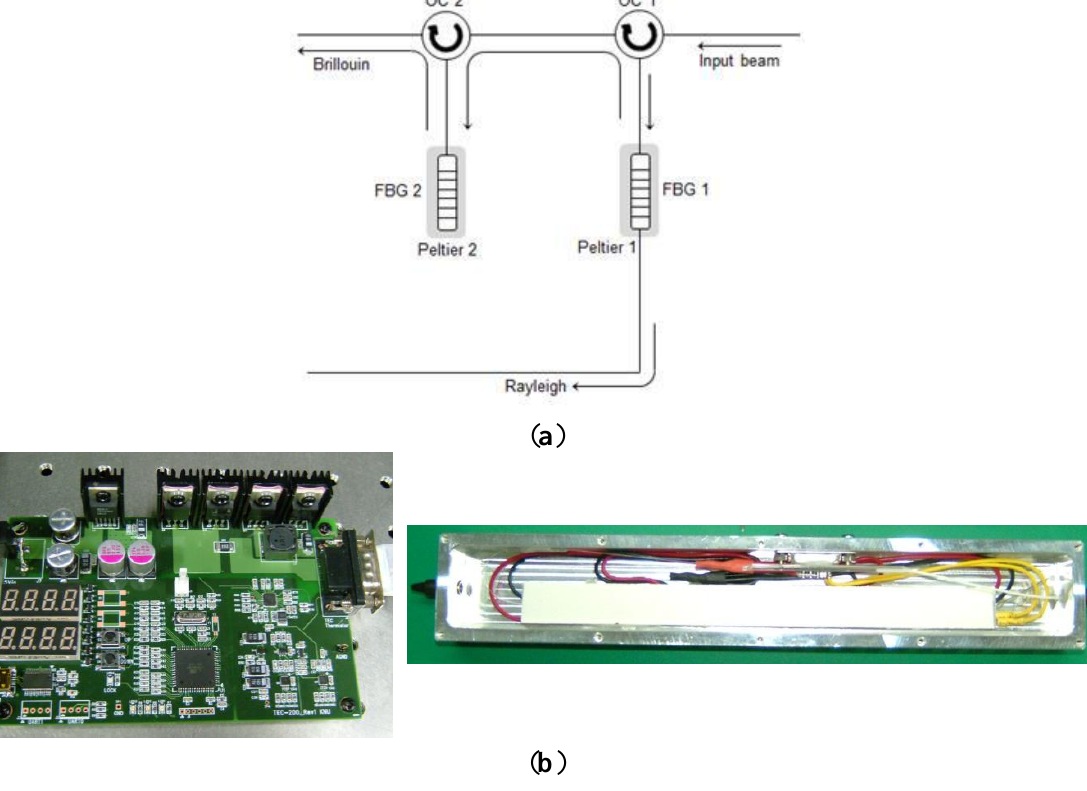
Figure 1. ( a ) The schematic diagram and ( b ) photograph of fabricated dual-stage FBG optical demultiplexer and temperature control